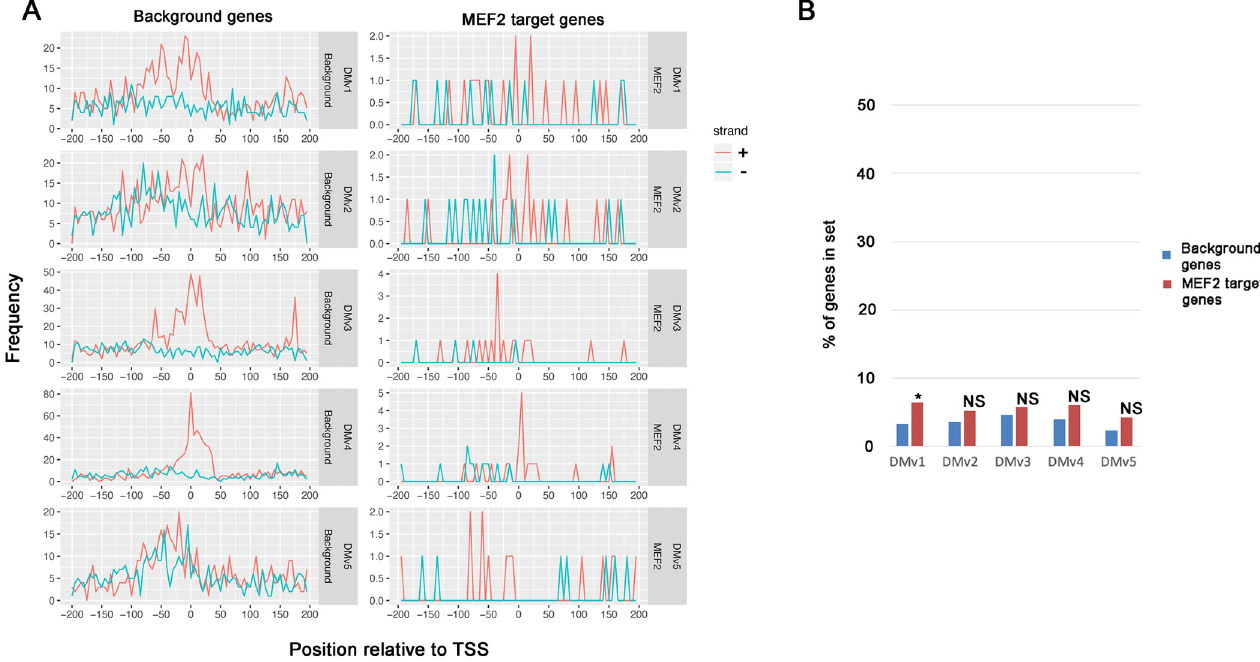
Fig 2. Occurrence of directional promoter motifs with variable locations (DMv) in control and MEF2 target genes. A: Frequency graphs showing the occurrence of each indicated motif in promoters from -200 to +200 relative to the transcription start site. Frequency data, representing the number of times that the element is detected at the indicated location, are shown separately for occurrences on the coding strand (+, red) versus the non-coding strand (-, blue). Graphs representing data from background genes are on the left of each pair of graphs, and MEF2 target genes are on the right of each pair. B: Relative frequencies of promoter elements in background and MEF2 datasets. NS, not significantly enriched in the MEF2 dataset; � , significantly P < 0.01) enriched in the MEF2 dataset.